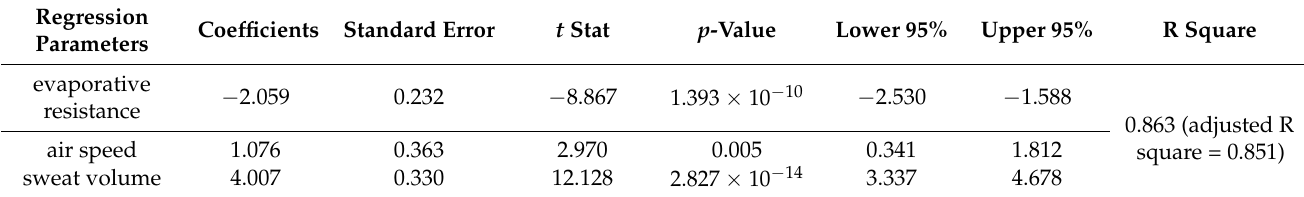
Table 5. Regression model of fabric sweat drying rate.